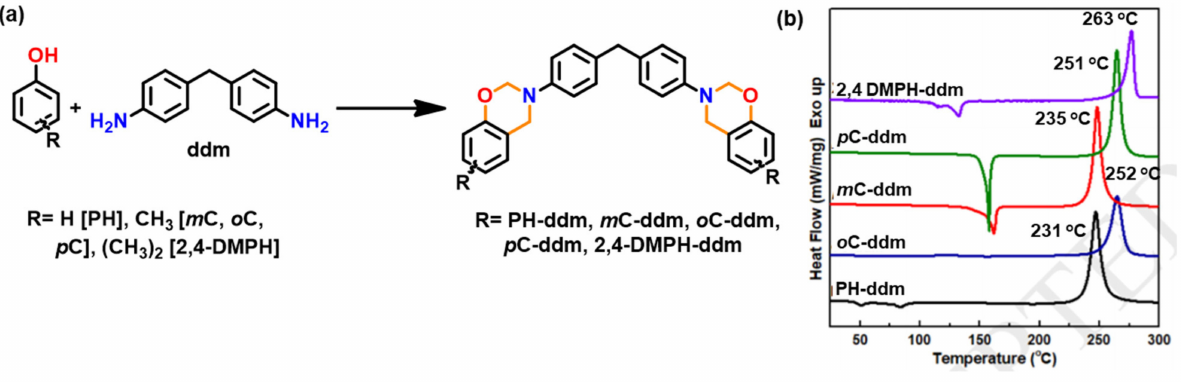
Figure 62. ( a ) Methyl substituted bis-benzoxazine monomers [167]. ( b ) DSC thermograms of aromatic diamine-based